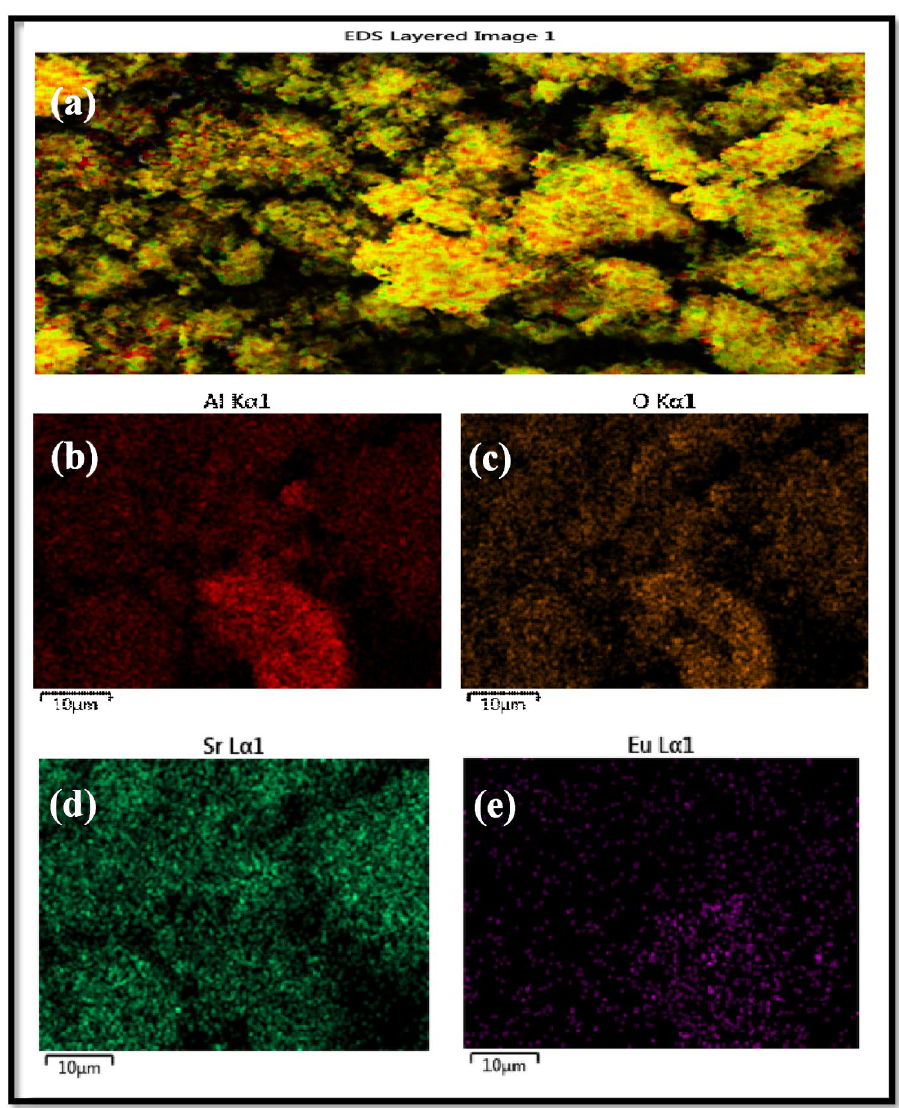
Figure 7. ( a – e ) Typical elemental mapping images for pure Sr 1−x Al 2 O 4 :Eu x (x = 0.05) phosphor (SAE